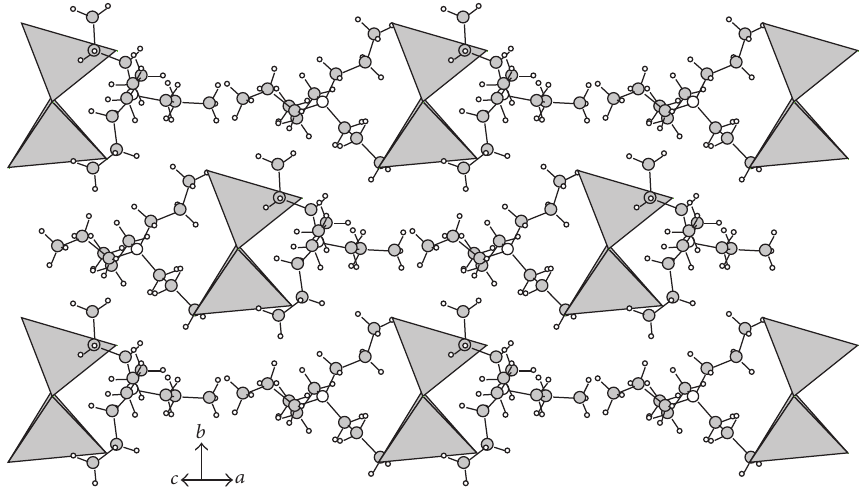
F 2: view showing the organic-inorganic layers staked along small and full circles represent nitrogen, hydrogen, and carbon atoms, respectively. [101]